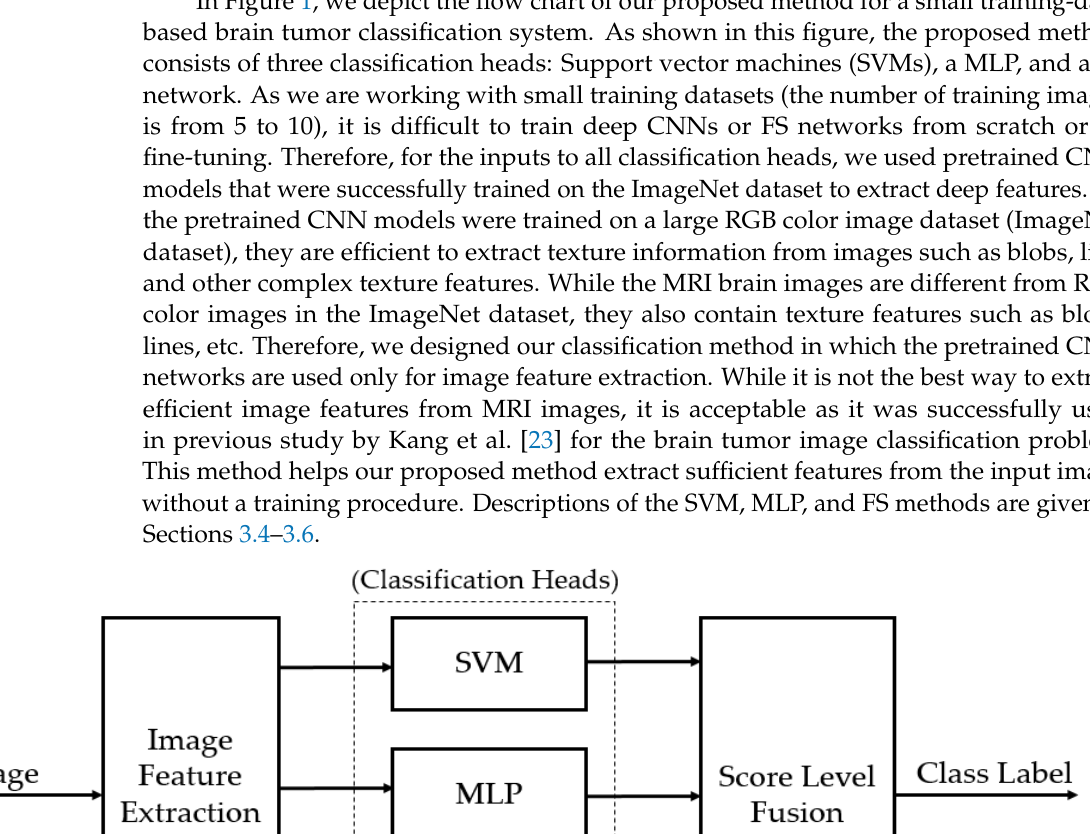
( d ) Figure 2. Example of preprocessing steps to extract the brain region image in our proposed method: ( a ) Captured brain image, ( b ) image after background removal with gray profiles in horizontal and vertical directions, ( c ) image with estimated brain ROI, and ( d ) final brain ROI image.